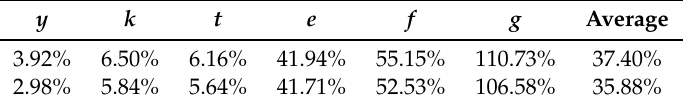
Table 14. Percentage difference from original